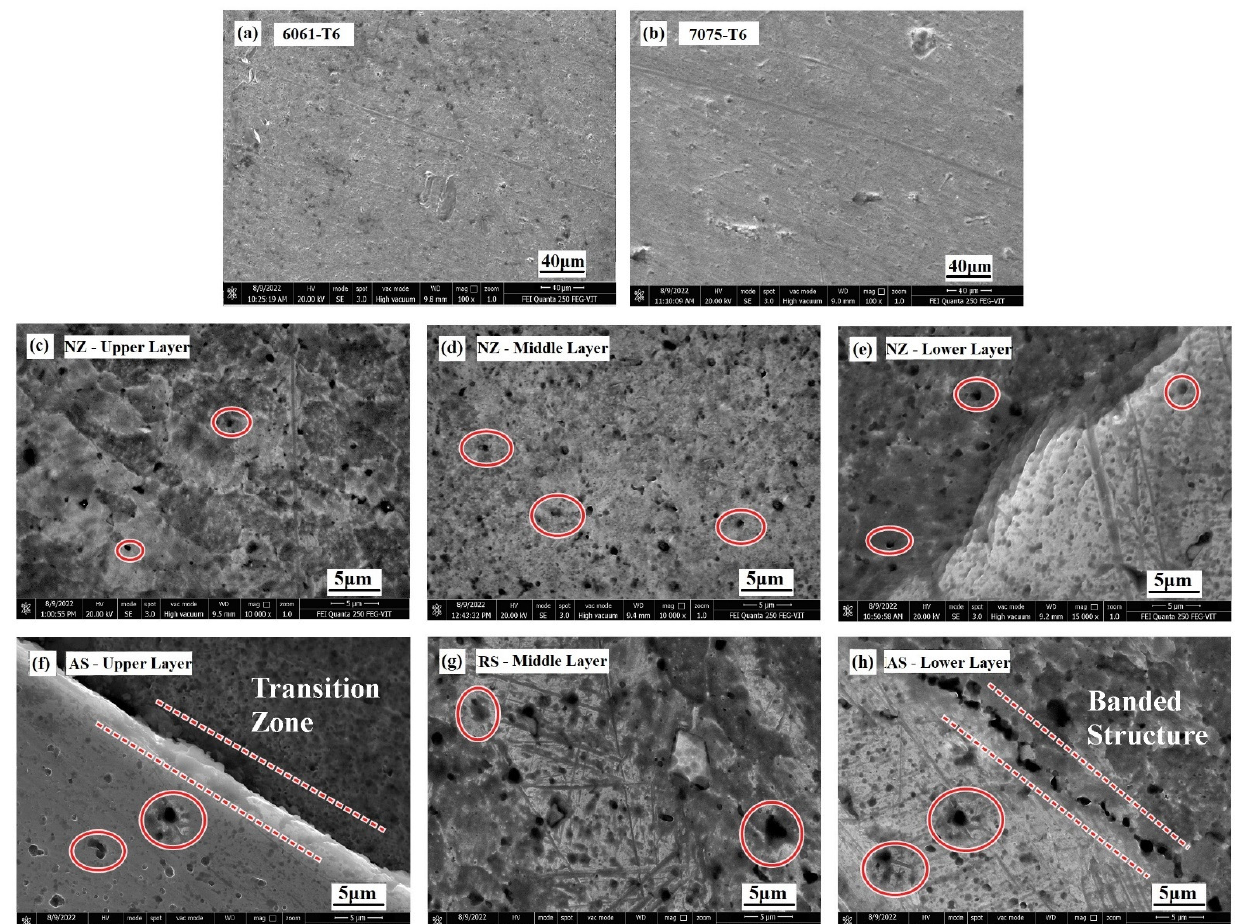
Figure 11. FE-SEM images of distribution of precipitates at various zones: ( a , b ) base metals AA6061- T6 and AA7075-T6, ( c – e ) NZ in upper, middle, and lower layer, ( f ) TMAZ of upper layer in AS, ( g ) TMAZ of middle layer in RS, and ( h ) TMAZ of lower layer in AS.